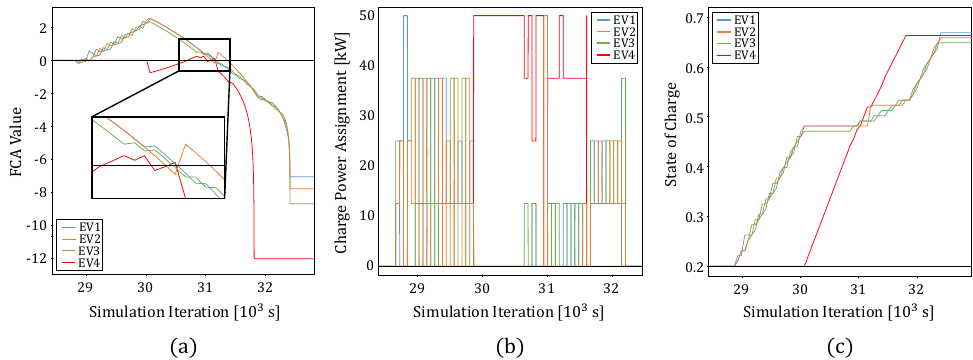
Figure 13. One against Three. ( a ) Feeding Compensation Account, ( b ) Charge Power and ( c ) State of Charge.